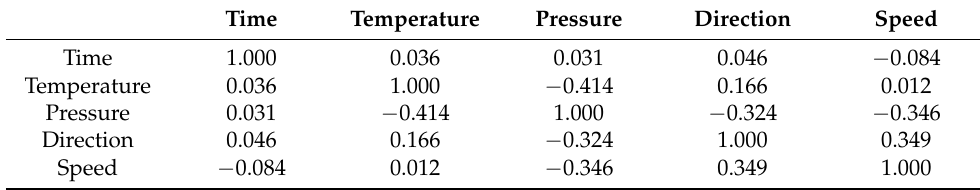
Table 3. Correlation matrix that shows the correlation coefficients between dataset variables.